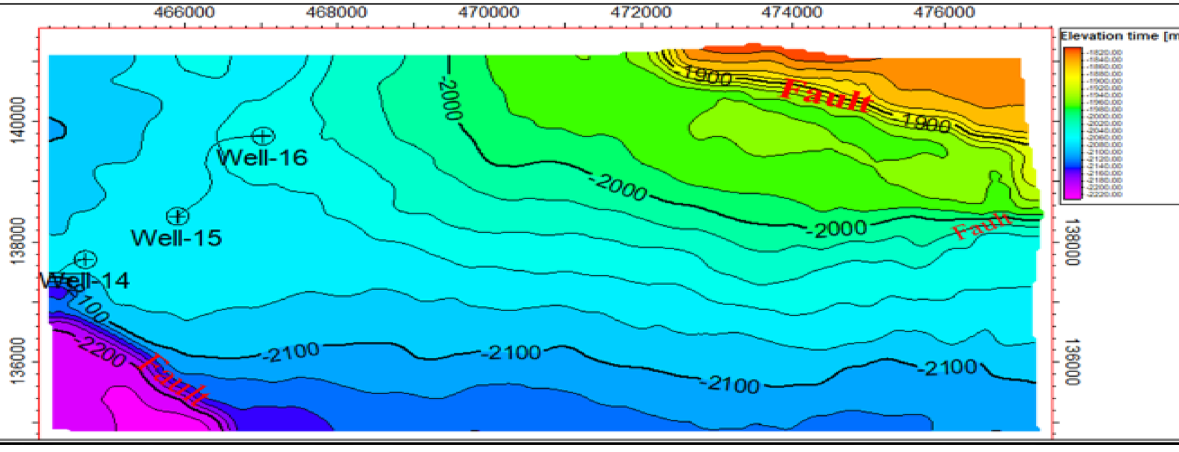
Fig. 8 Time structure map for H4